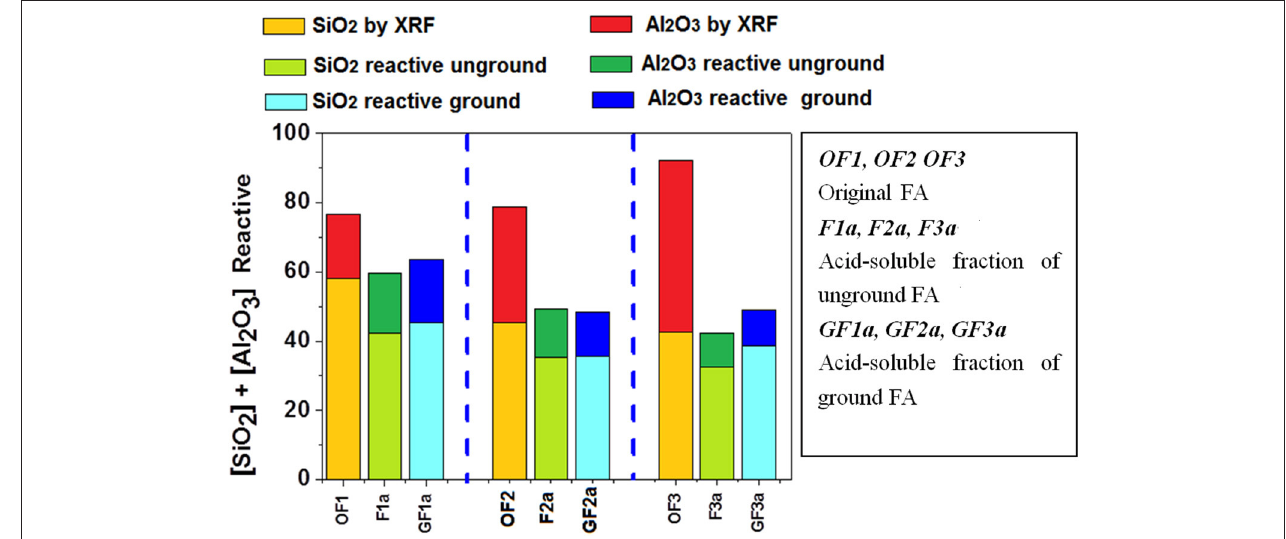
FIGURE 2 | Initial and potentially reactive silica and alumina in ground and unground